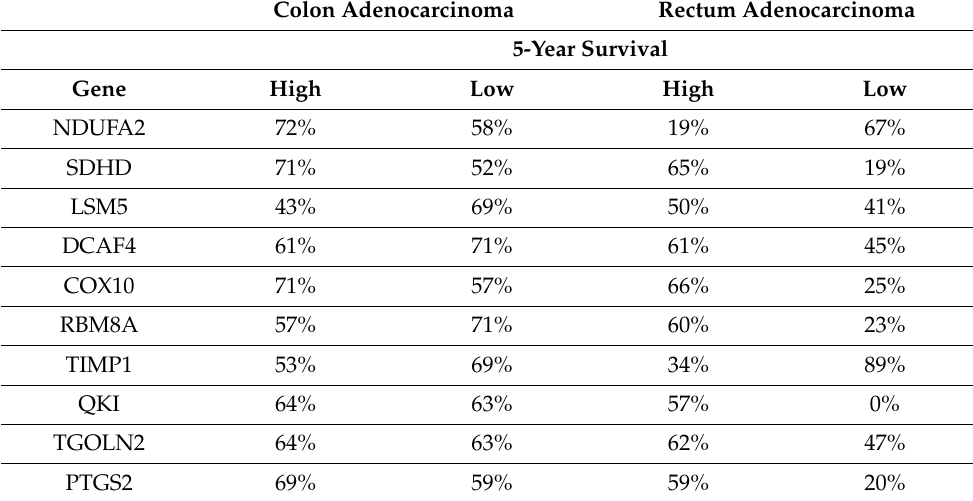
Table 4. The prognostic relationships between high and low expressions of specific genes involved in drug resistance to the overall survival of colon and rectum adenocarcinoma patients. Five-year survival factor obtained from the Human Protein Atlas (https://www.proteinatlas.org (accessed on 18 May 2022))